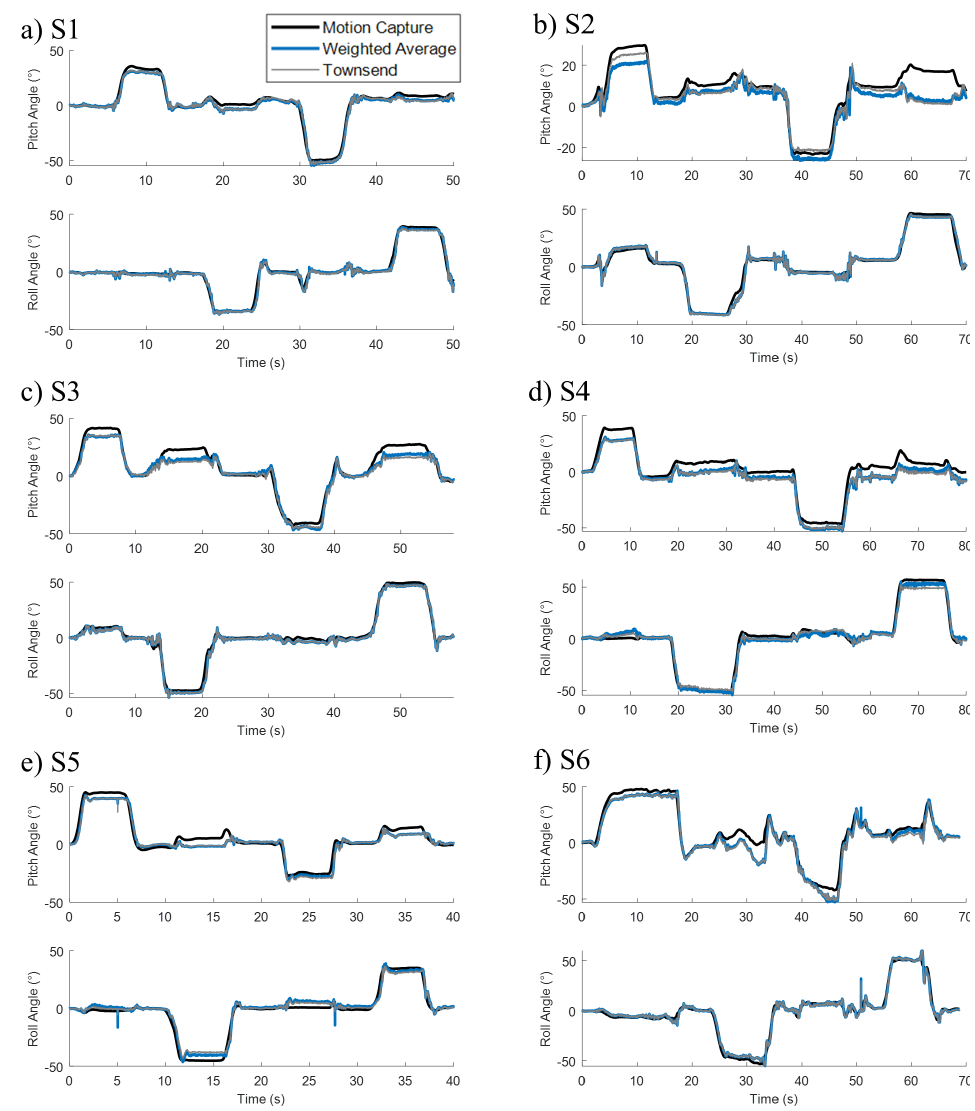
Figure 5. Pitch and roll angles from all subjects S1 ( a ), S2 ( b ), S3 ( c ), S4 ( d ), S5 ( e ), and S6 ( f ) determined through sensor fusion optimized with motion